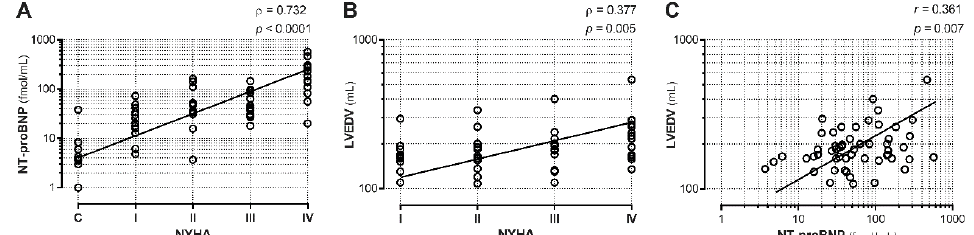
Figure 1. Correlation between heart failure severity indexes. Two markers of chronic heart